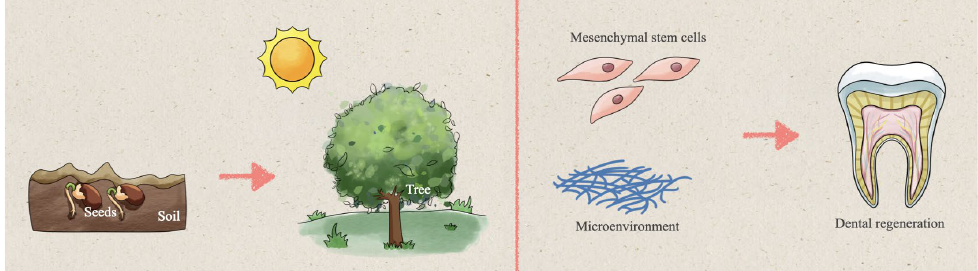
Figure 1. A schematic picture showing the relationship between mesenchymal stem cells and their microenvironment: the special microenvironment is to mesenchymal stem cells what soil is to seeds. Seeds grow slowly into trees under the nourishment of the soil just as mesenchymal stem cells strive to develop in their microenvironment, aiming to reach the goal of tissue regeneration.